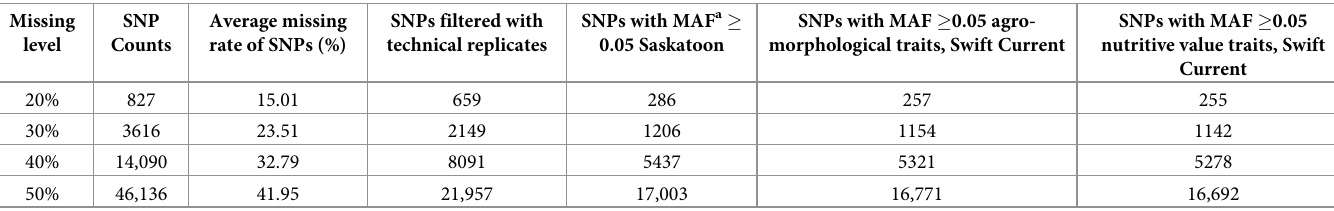
Table 5. Counts of SNPs at four levels of missing data and different filtering